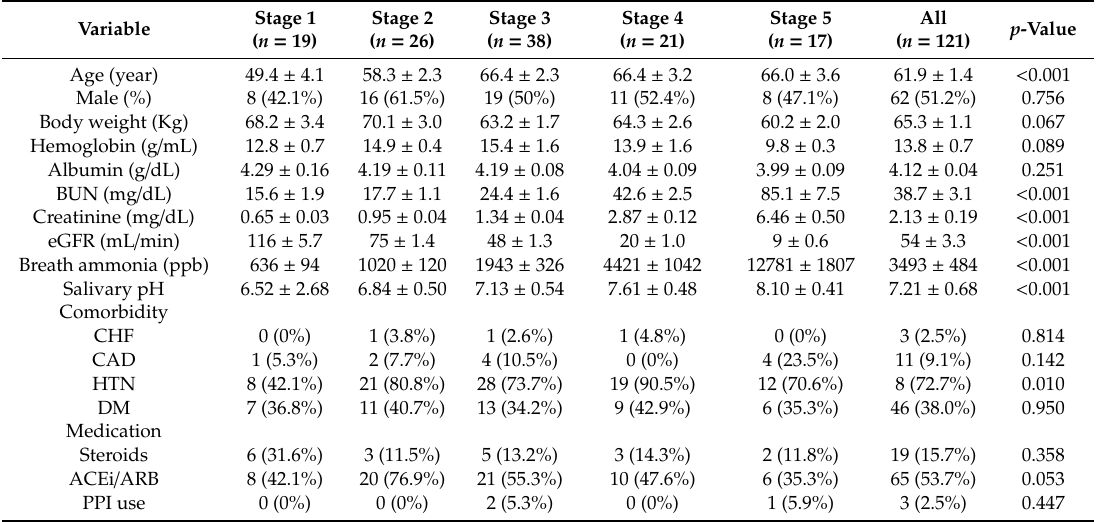
Table 1. Patient characteristics by di ff erent chronic kidney disease (CKD)